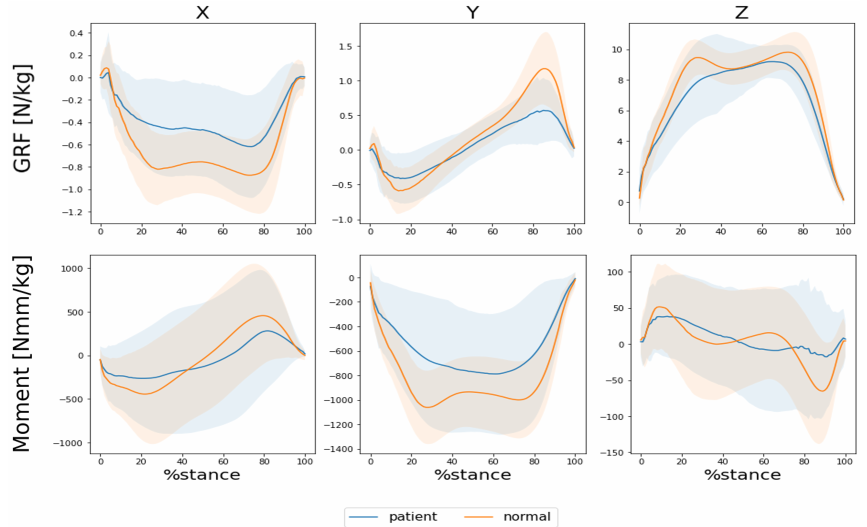
Figure 5. Results of measured time-series data using the force plate. Data from the stance phase in the gait cycle are measured during the one-step gait cycle, and those of the swing phase are not recorded in the experiment. The normalized time for 0 ∼ 25% expresses the initial contact, 25 ∼ 80% expresses the midstance, and 80 ∼ 100% expresses the propulsion.